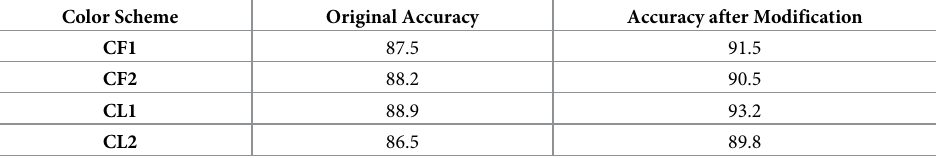
Table 9. Effect on the accuracy of the classifier after label modification and counting correct predictions in terms of set-membership.